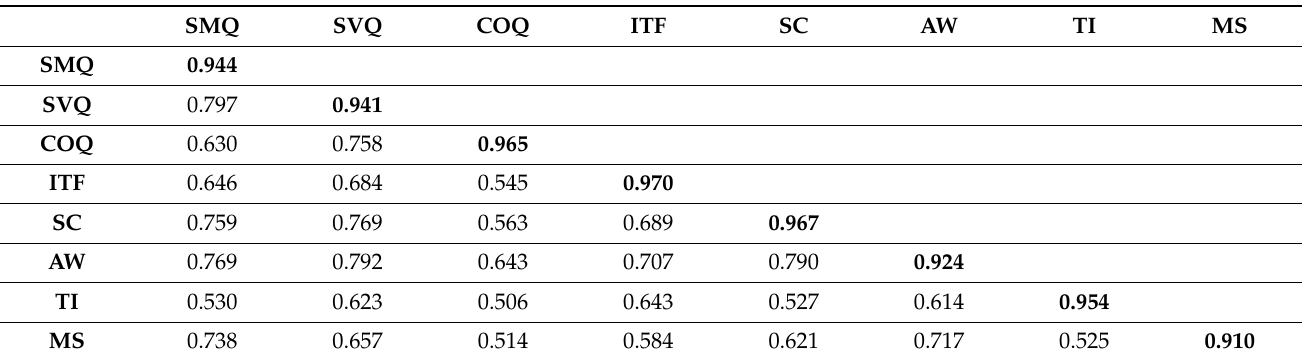
Table 2. Discriminant validity